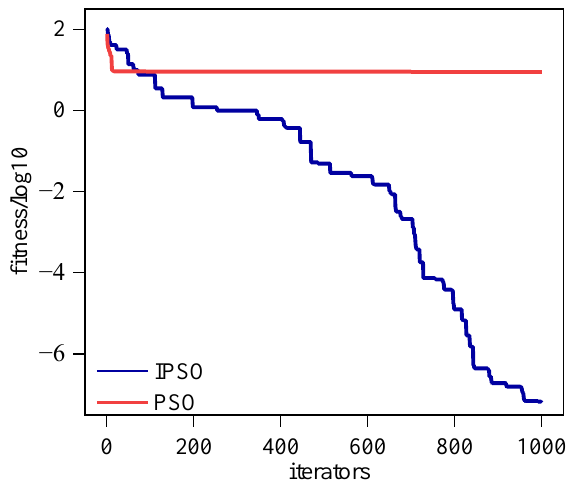
Figure 4. The optimal results of the extremum for the 5 dimensional sphere function. Figure 4 manifests that the PSO falls into the locally optimal solution with an